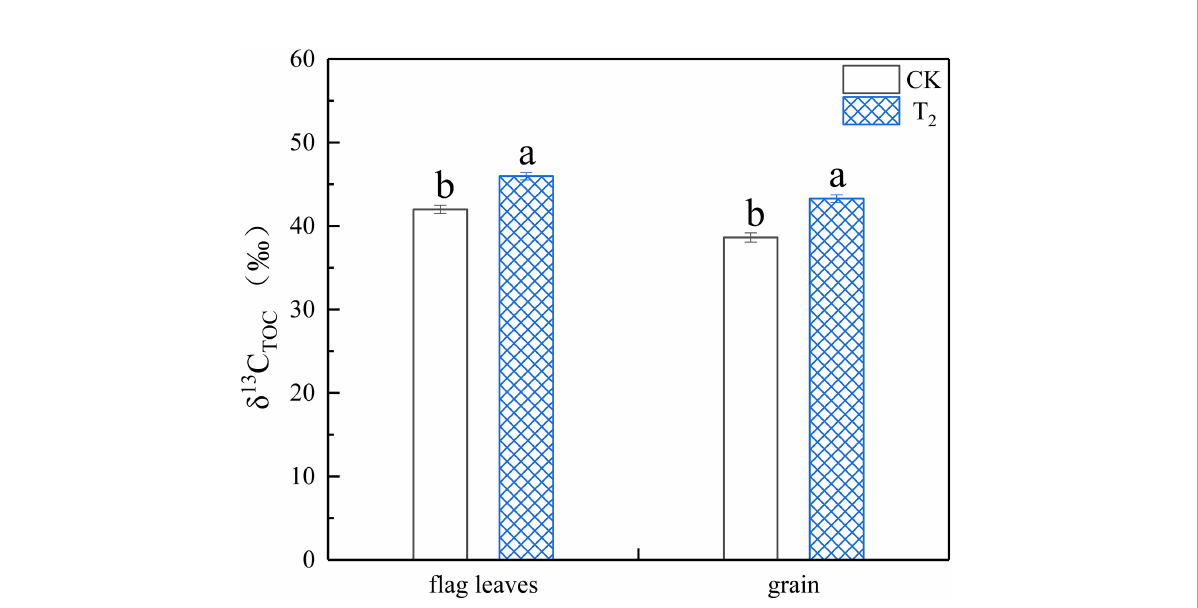
FIGURE 6 The effect of exogenous 6-BA on fl ag leaves and grain d 13 C of wheat under waterlogging and shading treatment of 11 days in 2021. CK refers to the control sprayed with distilled water. T 2 : the concentration of 6-BA sprayed is 25 mg·L − 1 . Shade nets with a shading rate of about 45% were used for shading, and waterlogging preserves about 2 cm of moisture on the surface of the soil. Each value is expressed as mean ± SE ( n = 3). Different lowercase letters embedded at the top of the histogram express signi fi cant differences among treatments ( p<